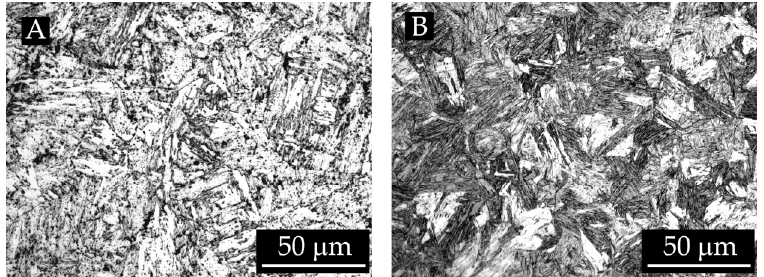
Figure 3. OM micrographs of the initial forging bush after austenitization at 890 °C for 4 h, water quenching and tempering at 620 °C for 6 h ( A ) and of test ring samples after austenitization at 890 °C for 4 h and water quenching in laboratory scale furnace ( B ).